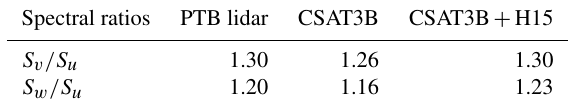
Table 2. Ratios between the spectral densities of the different wind components in the inertial subrange (at frequencies between 0.5 and 1s − 1 ) measured by the lidar and the sonic anemometer, with and without the H15 flow distortion correction. Note that both ratios S v /S u and S w /S u should theoretically be 4 / 3 assuming isotropic turbulence (Kaimal and Finnigan,